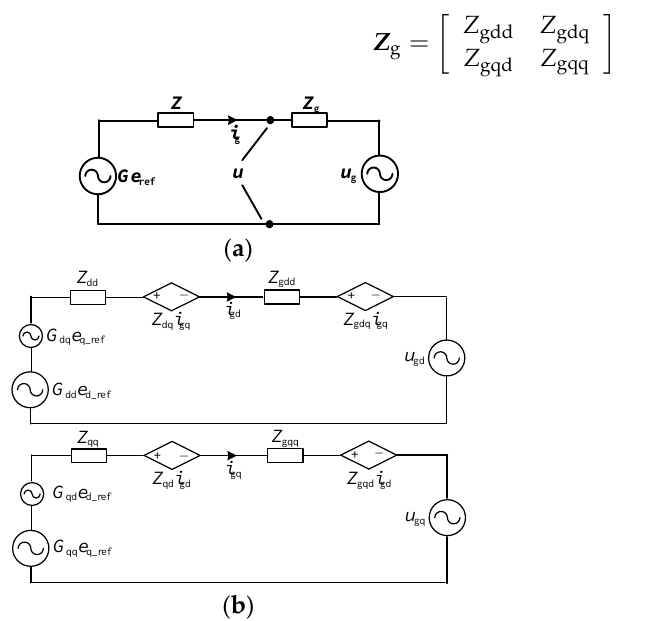
Figure 4. Impedance model of a single VSG. ( a ) Composite impedance model in the d-q coordinate of a single VSG; ( b ) Decomposition impedance model in the d-q coordinate of a single VSG.